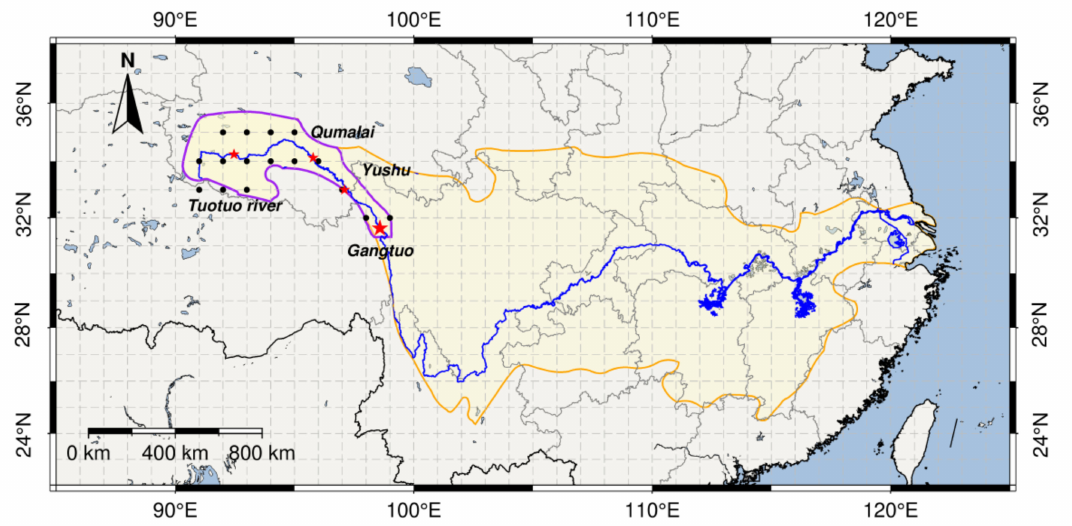
Figure 1. Yangtze River source region (bounded in purple) within Yangtze River Basin (bounded in yellow), with meteorological and hydrologic stations (denoted by red